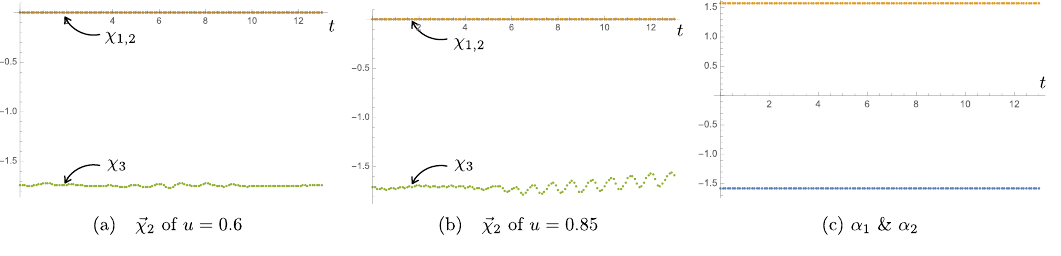
Figure 8 . Evolution of ~χ 2 = ~χ ( X 2 ( t ) , Y 2 ( t )) for u = 0 . 6 and u = 0 . 85 .